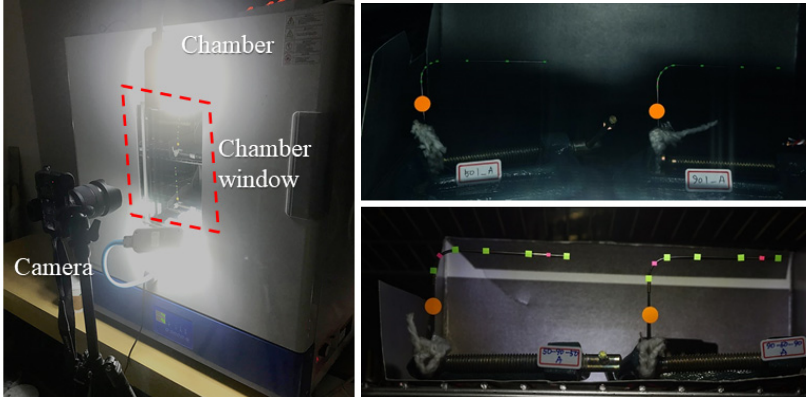
Appl. Sci. 2020 , 10 , x FOR PEER REVIEW Figure 5. Test and measurement set-up and specimens in chamber. Figure 5. Test and measurement set-up and specimens in chamber.